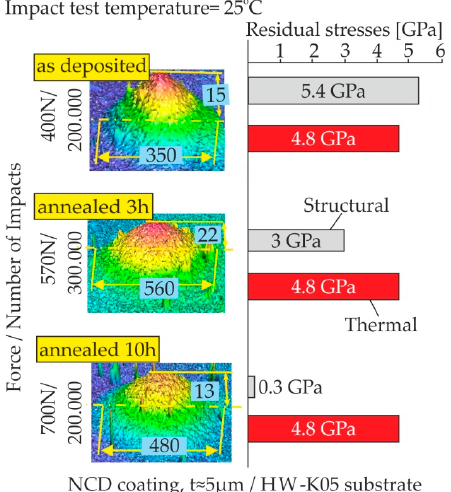
Figure 6. FEM-calculated thermal and structural stresses in the investigated coating cases based on the dimensions of the developed bulges after inclined impact tests and appropriate evaluation by using FEM-DRS and FEM-TRS algorithms. FEM-DRS and FEM-TRS